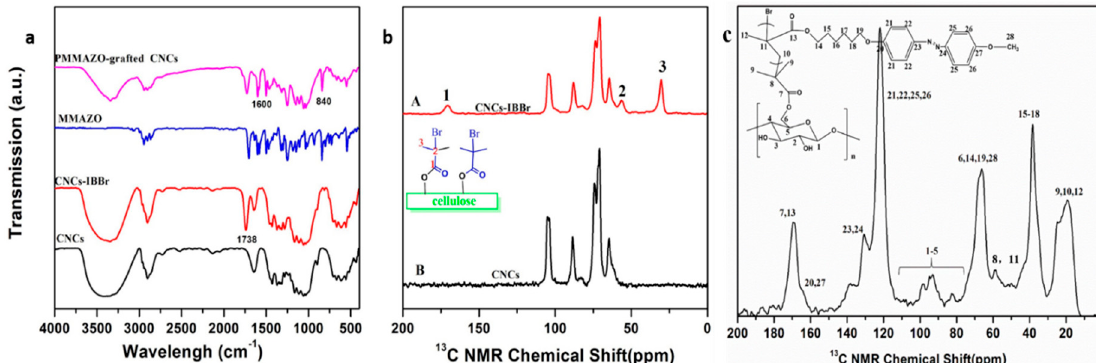
Figure 2. FT-IR structural characteristics of: ( a ) pure CNCs, CNCs-IBBr, MMAZO, and PMMAZO- grafted CNCs; ( b ) MAS 13C NMR spectrum of pure CNCs and CNCs-IBBr; and ( c ) MAS 13C NMR spectrum of PMMAZO-grafted CNCs.